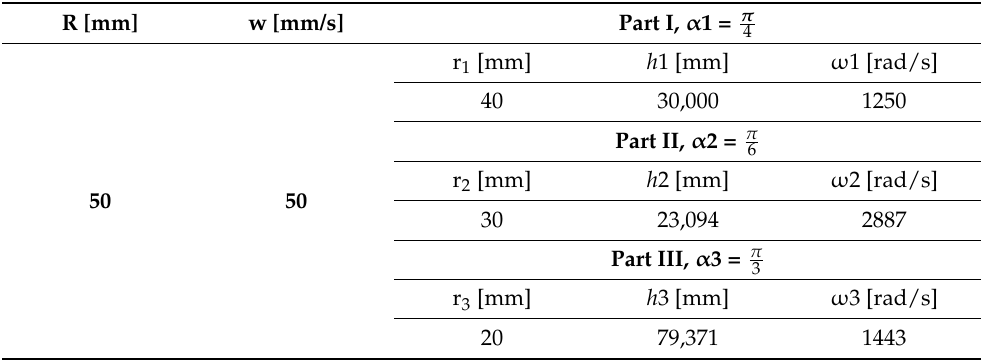
Table 3. An overview of the calculated values of the distance h of the winding plane from the guide-line k1 and the rotational angular speed ω of the guide-line for individual parts of the frame. Constant speed of passage of the frame through guide-line k1 is equal of value w = 50 [mm/s]. R [mm] w [mm/s] Part I, α 1 = π